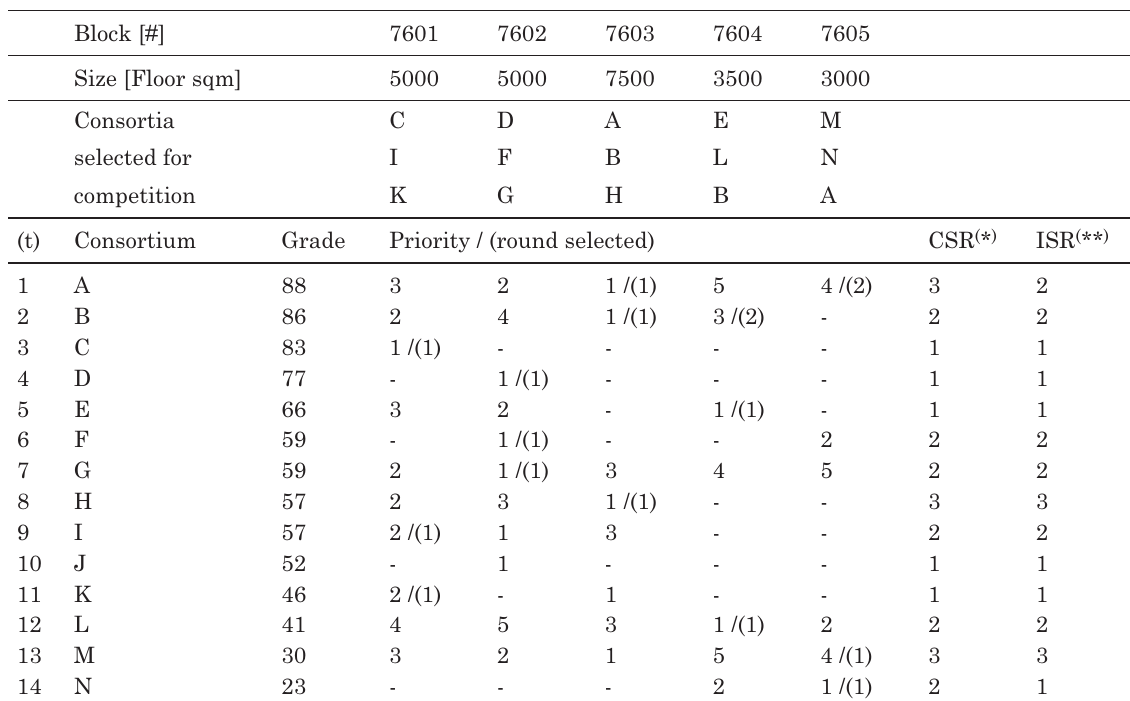
Table 5. Results of